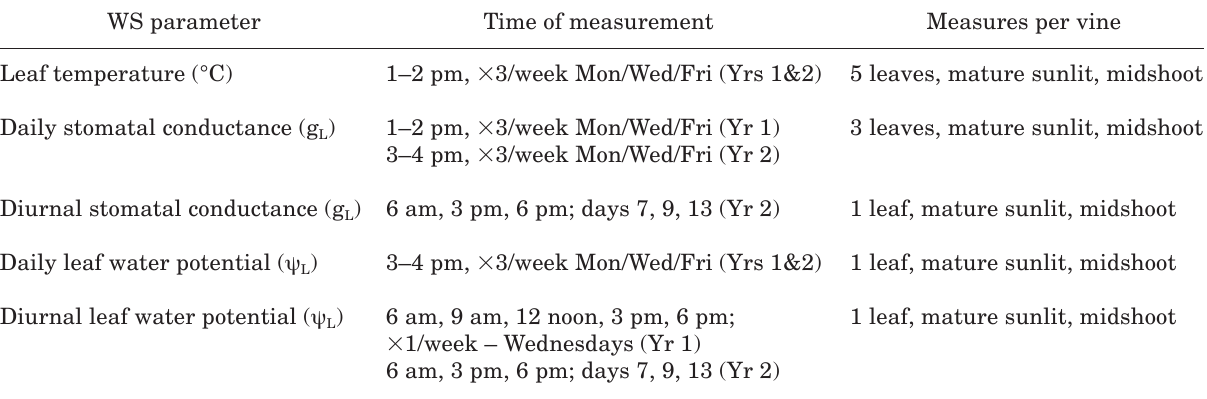
Table 1. Measurements of water stress (WS) in experimental grapevines, years 1 and